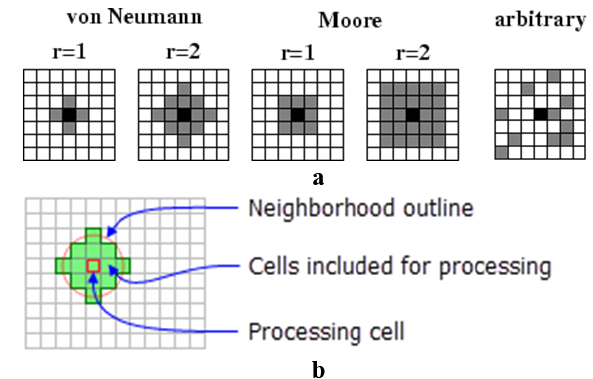
Figure 1. Examples of different neighbourhoods: a) rectangular and b)